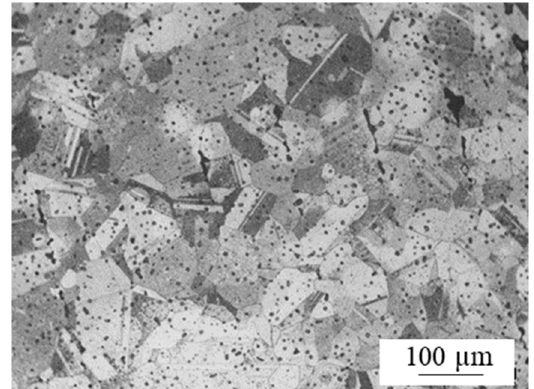
Figure 11. Microstructure of the sintered BMD parts.